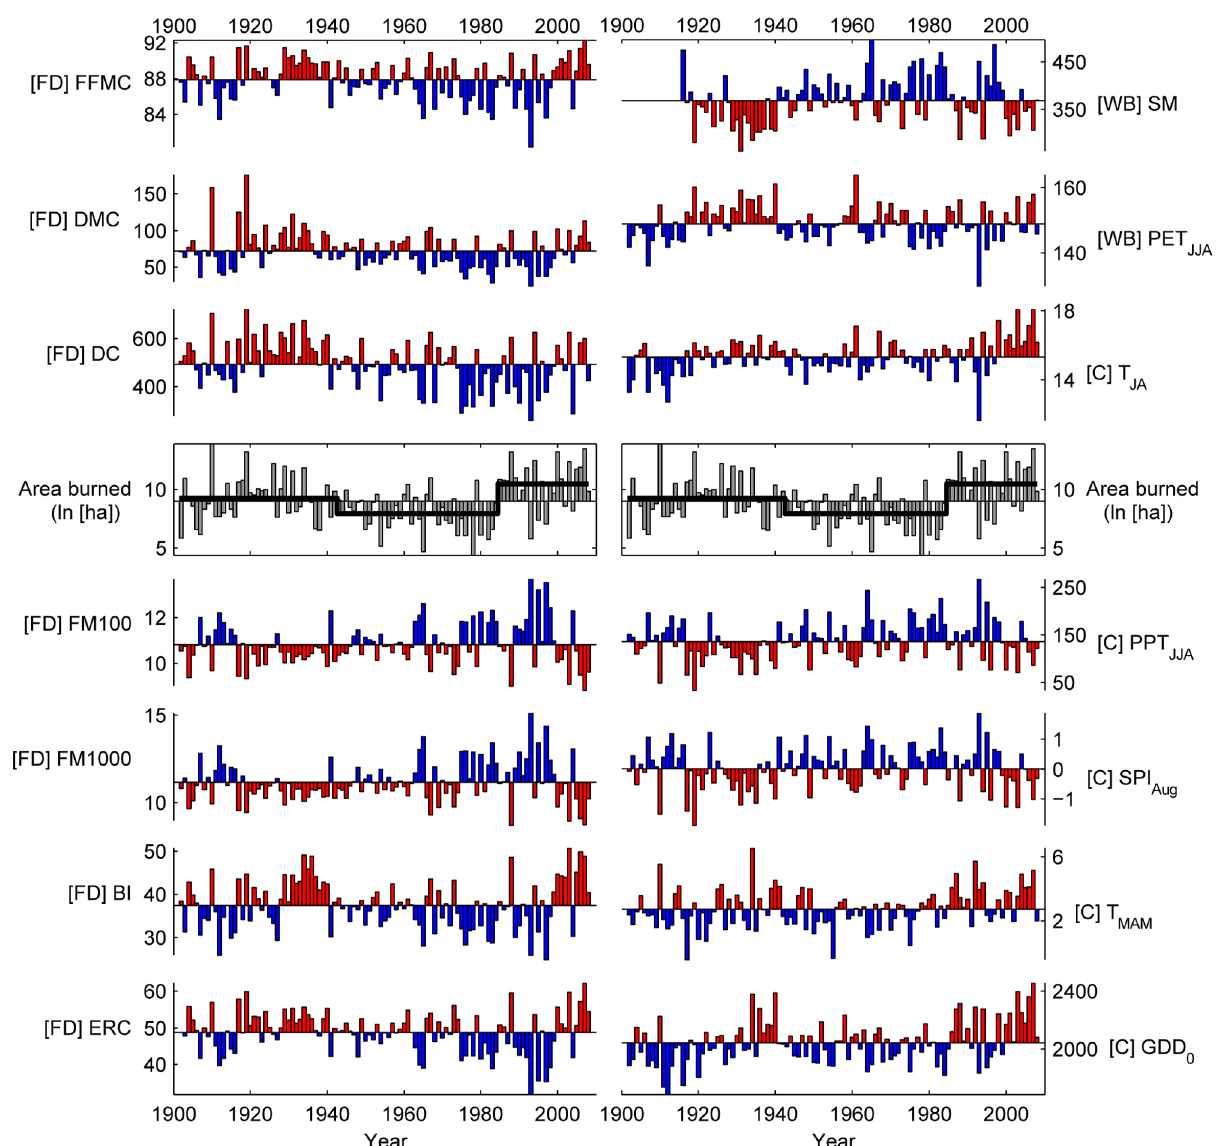
Fig 3. Fire-danger, water-balance, and climate predictors of annual area burned. Series are plotted relative to the series mean, with red (blue) representing above (below) average conditions conducive for fire activity. The center row includes annual area burned (gray), expressed as ln(ha), with average values for each of three periods identified via piecewise linear regression (1902 – 1942, 1943 – 1984, 1985 – 2008). Metrics are organized based on their overall score (upper left to lower right; Table 2). Metric type is identified as “ FD ” (fire danger), “ WB ” (water balance), or “ C ” (climate), with units and temporal definitions listed in Table